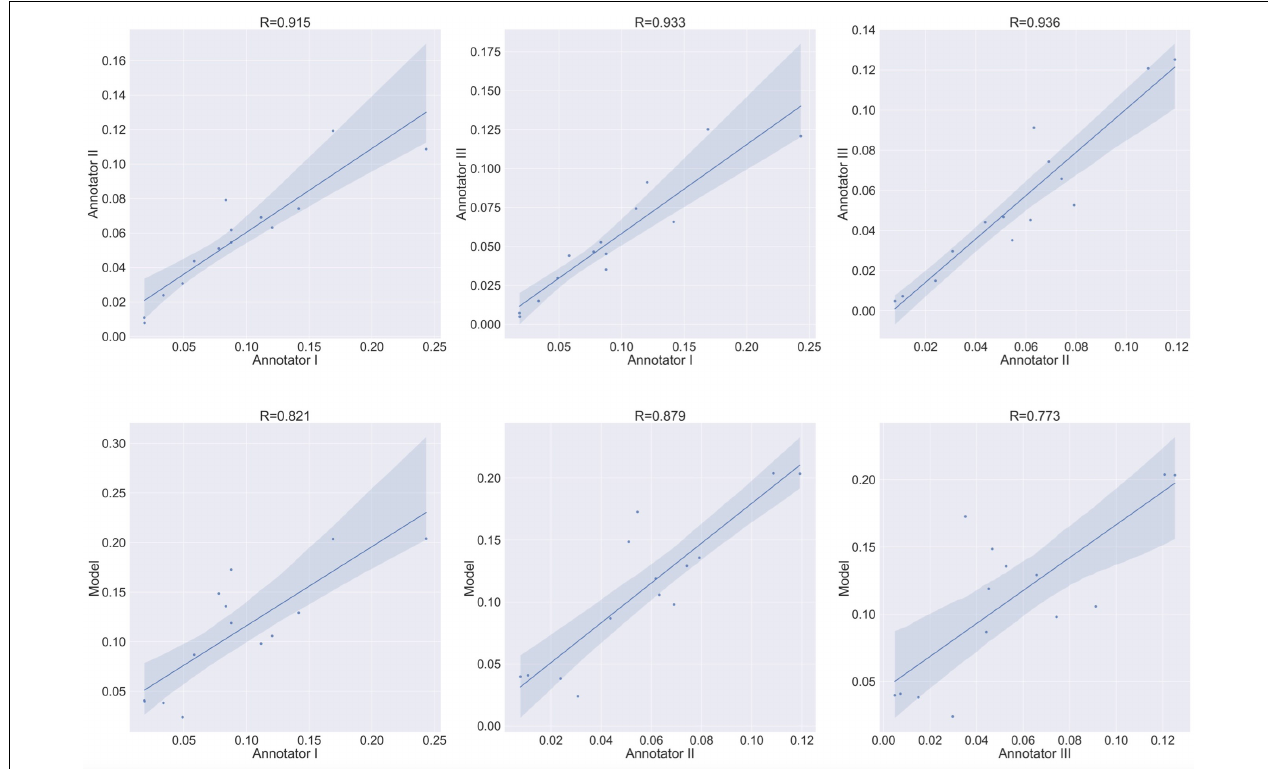
FIGURE 10 | Area estimation task for osteoclasts Type 1. Upper row: correlation between each annotator on a single culture and the other two annotators on the area estimation task. Bottom row: correlation between each annotator and the model’s prediction on the area estimation task.